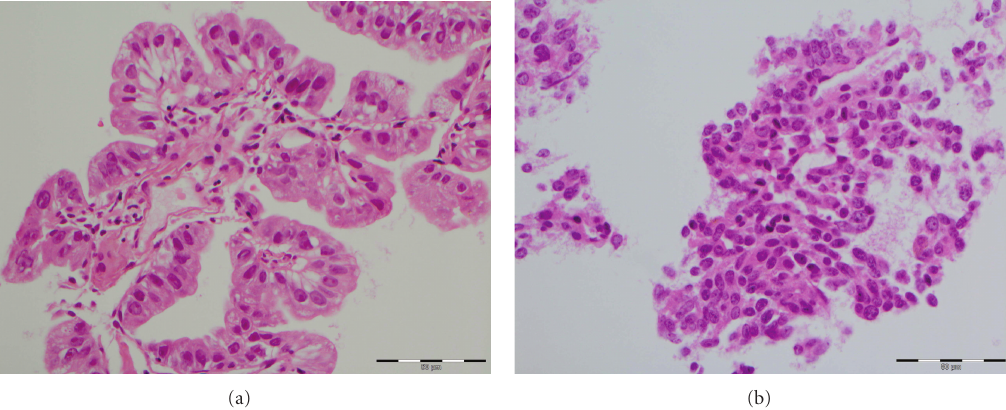
Figure 3: Histology of pulmonary specimen. H&E staining. Original magnification × 200. Histology demonstrates typical cuboidal cells with granules. Specific immunostaining (not shown) was strongly positive for ACTH, CD56, chromogranin and